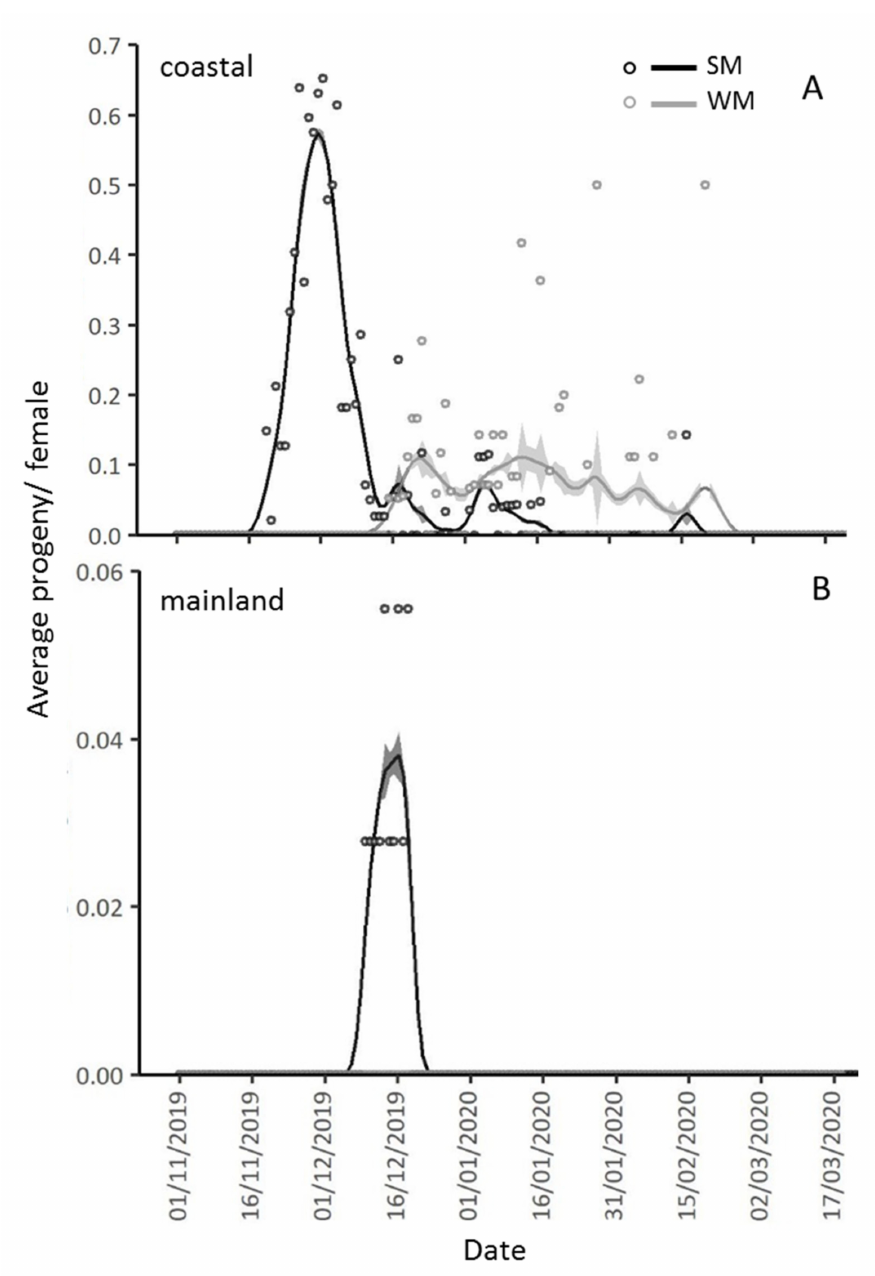
Figure 9. Gaussian Kernel smoothing curves and standard errors (grey zones above and below the smoothing curves) for average daily pupae (circles) per SM and WM female, exposed since 1 November 2019 in the coastal (Volos) and the mainland area (Naousa). In the coastal area, pu- pae production started 20 days after SM females were transferred to the field and lasted 58 days (from 20 November 2019 to 17 January 2020). Pupae production by WM females in the coastal area started 46 days after their transfer to the field and lasted 67 days (from 16 December 2019 to 21 February 2020) ( A ). In the mainland area, pupae production was recorded 40 days after SM fe- males were transferred to the field and lasted 9 days (from 10 December 2019 until 19 December 2019) while no pupae were produced by WM females in this area ( B